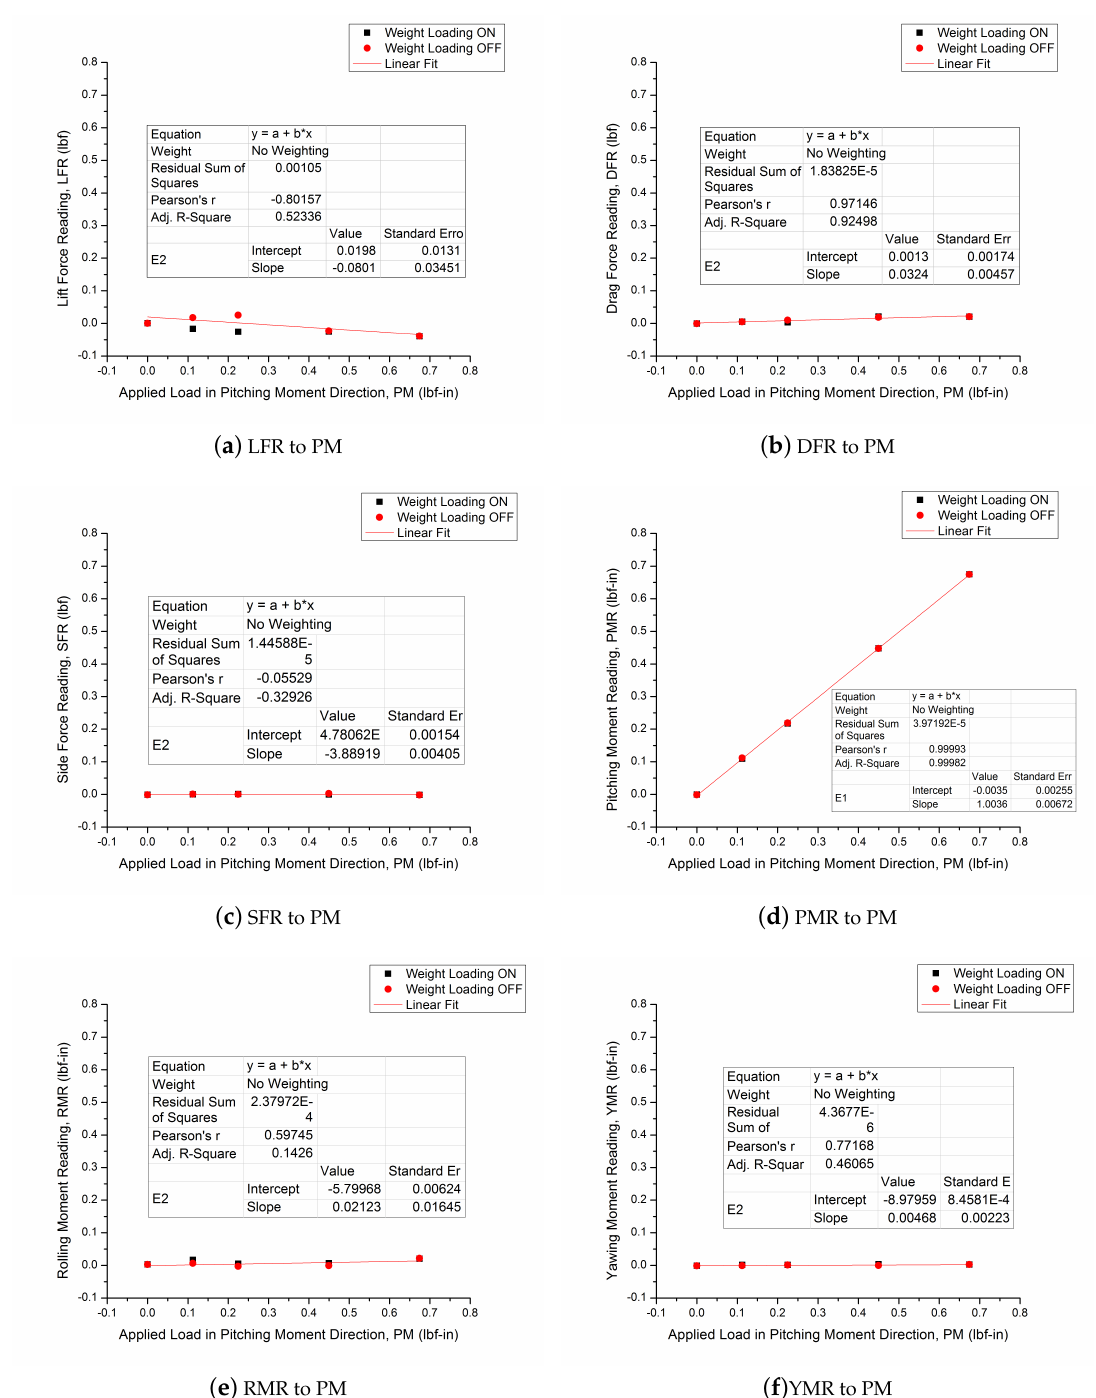
Figure A4. Experimentally obtained wind tunnel pyramidal balance interactions upon applied load in pitching moment